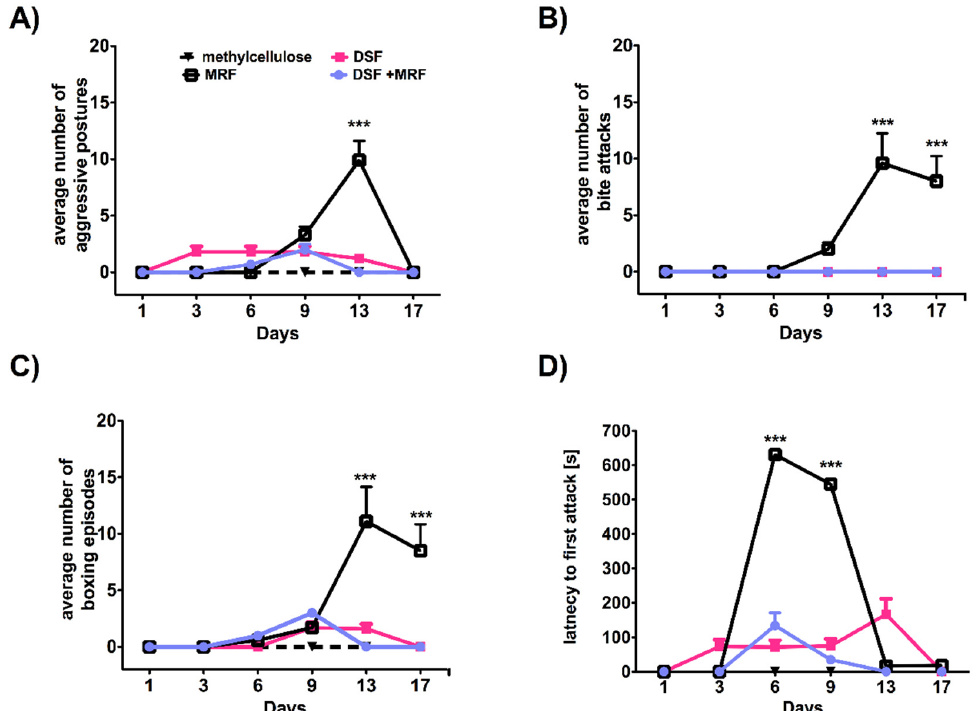
Figure 5. Aggression-like behavioral parameters recorded for rats intraperitoneally treated with DSF-, MRF- or its mixture. ( A ) Average number of aggressive postures; ( B ) Average number of bite attacks; ( C ) Average number of boxing episodes; and ( D ) Latency to first attack. Aggressive interactions were recorded on days 1, 3, 6, 9, 13, and 17, for 60 min, immediately after drug administration. Two-way ANOVA, followed by Bonferroni’s post hoc test, revealed significant differences for MRF vs. DSF + MRF (***). Although differences between MRF and methylcellulose, DSF and methylcellulose, DSF + MRF vs. methylcellulose, and DSF vs. DSF + MRF occurred in each experiment, they are not shown in the figure; n = 10 animals (male Wistar rats)/group.